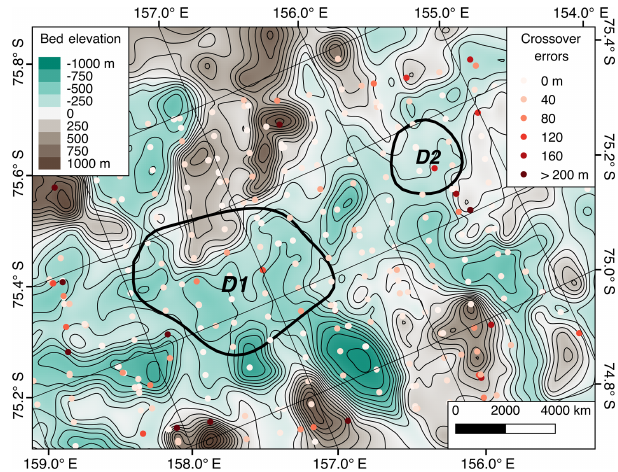
Figure 4. Bed elevation DEM generated from KOPRI data, with 100m contours and errors in bed elevation between intersecting lines. Lake outlines from Smith et al. (2009) are